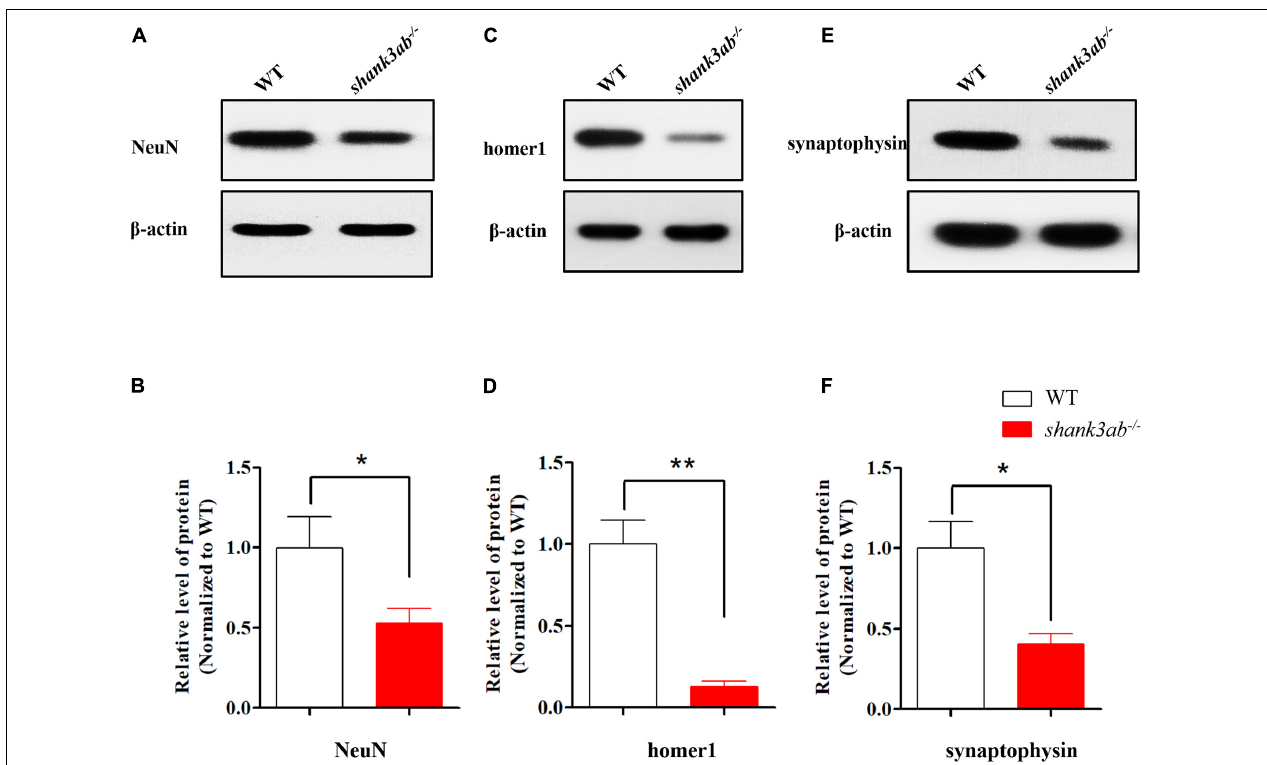
FIGURE 4 | shank3 deficiency resulted in the reduction of synapse-related proteins in adult zebrafish brain. (A,B) Quantitative immunoblot blot analysis showed that the neuron protein NeuN was significantly decreased (50% of WT) in the s hank3ab - / - male zebrafish brain relative to WT zebrafish (3.5 mpf). (C,D) The expression of post-synaptic homer1 protein was markedly reduced in s hank3ab - / - male zebrafish brain compared with that of WT zebrafish (3.5 mpf, 10% of WT). (E,F) The expression of presynaptic synaptophysin protein was significantly reduced in s hank3ab - / - male zebrafish brain compared with that of WT zebrafish (3.5 mpf, 36% of WT). N = 3 for each group. Data are presented as mean ± SEM; * P < 0.05, ** P <